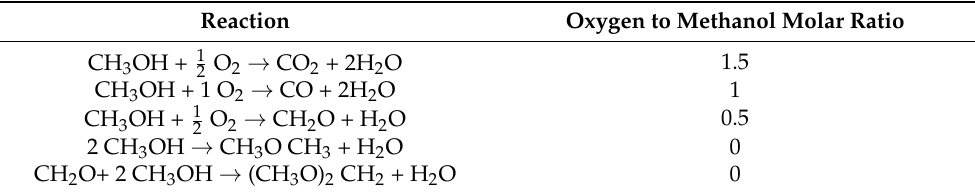
Table 5. Oxygen usage per converted methanol in a MoO 3 / Fe 2 (MoO 4 ) 3 system. Reprint from [99]. Copyright (2021), with permission from Springer Nature.